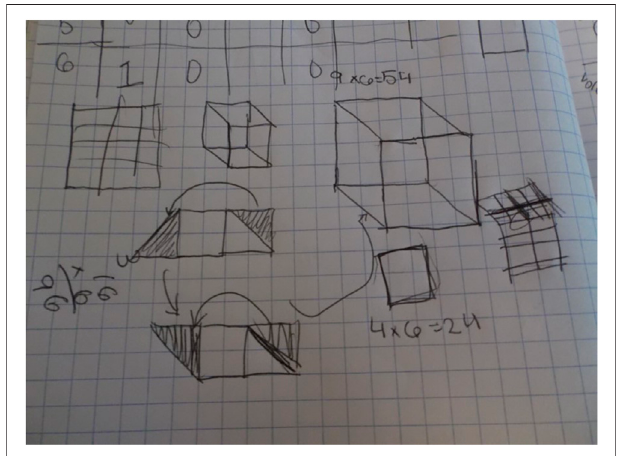
FIGURE 4 | Drawings of cubes from student notebook.